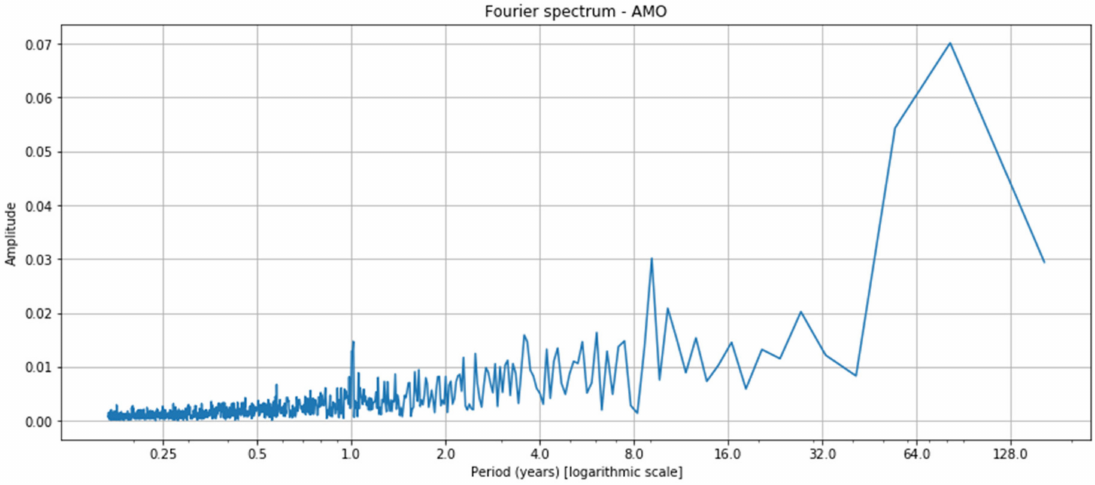
Figure 20. Fourier spectrum of the AMO index.